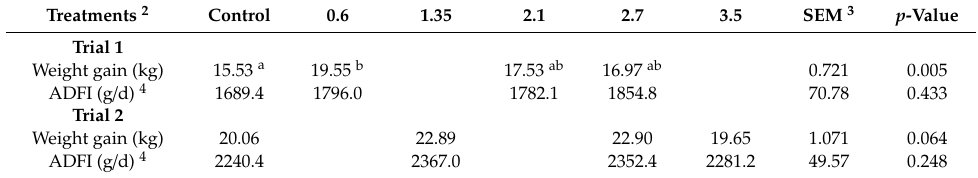
Table 2. E ff ect of the dilution ratio on performance in growing–finishing pigs 1